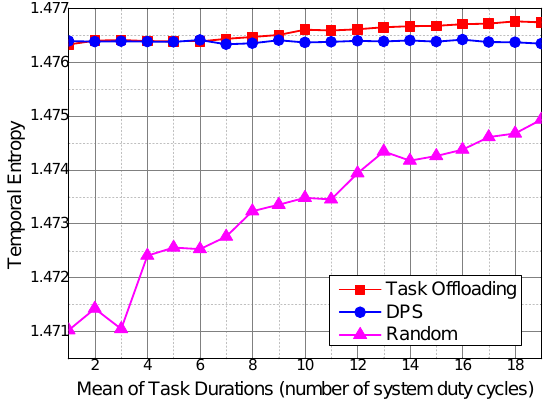
Figure 12. Temporal entropy under different mean values of task durations.